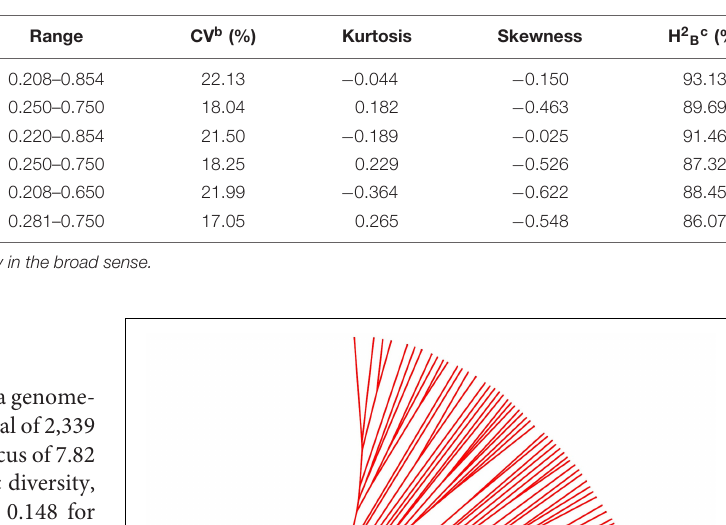
TABLE 1 | Phenotypic variation for chilling tolerance of the total accessions and the two subspecies.